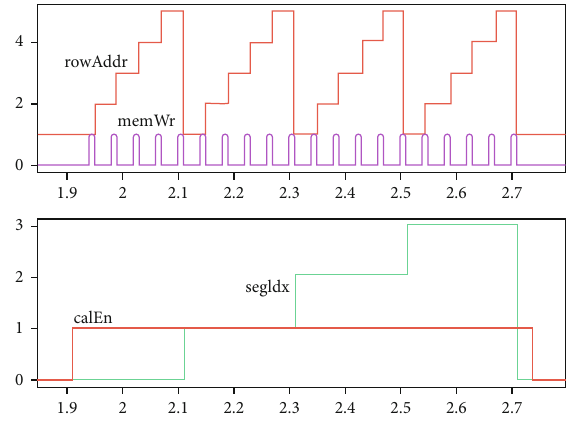
Figure 7: Timing behavior of segmented